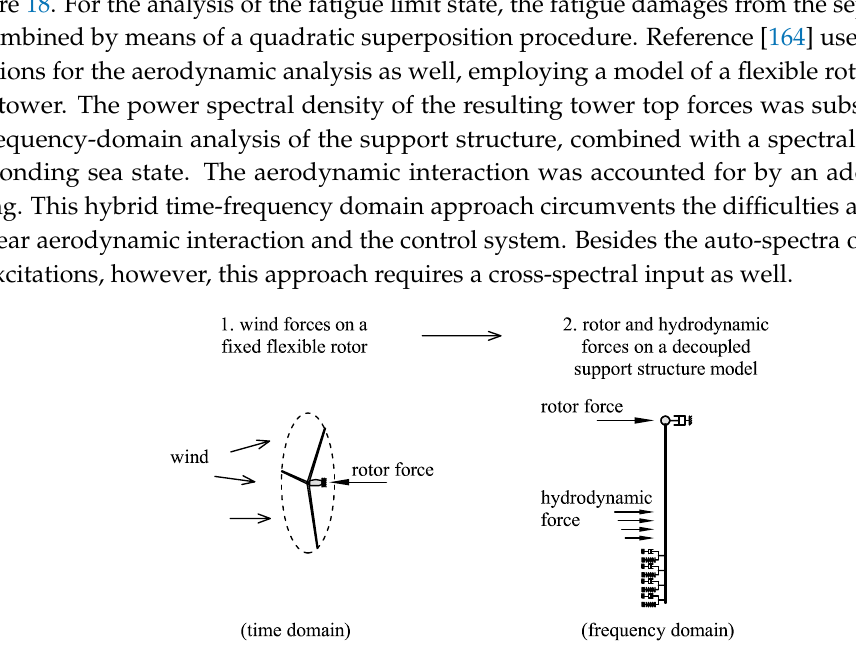
Figure 18. Schematization of the hybrid analysis by [65]. Regarding the properties of the decoupled model, reference is made to Figure